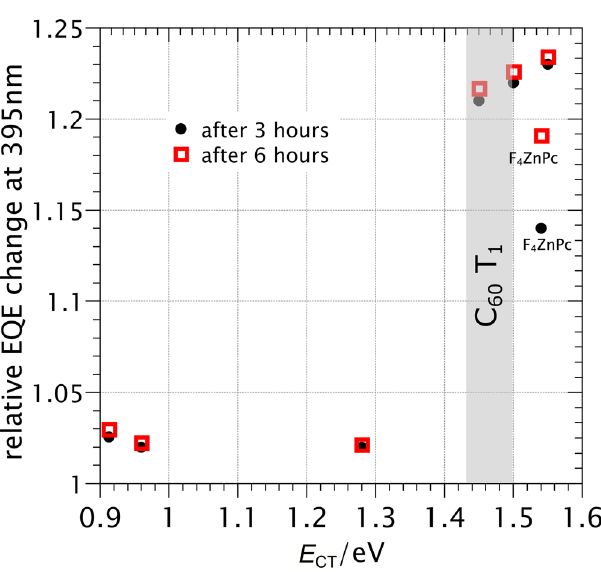
Fig. 2 In fl uence of CT energy on dimerization. Relative change in EQE after exposure to simulated sunlight (xenon lamp) for dilute 6% molar D:C 60 blends with various CT energies. The relative EQE change is de fi ned as the normalized EQE value of Fig. 1 at 395 nm after 3 (black circles) or 6 hours (open red squared) divided by the initial normalized EQE value at 395 nm. The shaded area represents the reported C 60 T 1 energy range 38, 39 . F 4 ZnPc: C 60 (annotated) represents a special case, as the donor triplet energy (1.13eV) is lower than the E T1 , which is not the case for the other materials 27